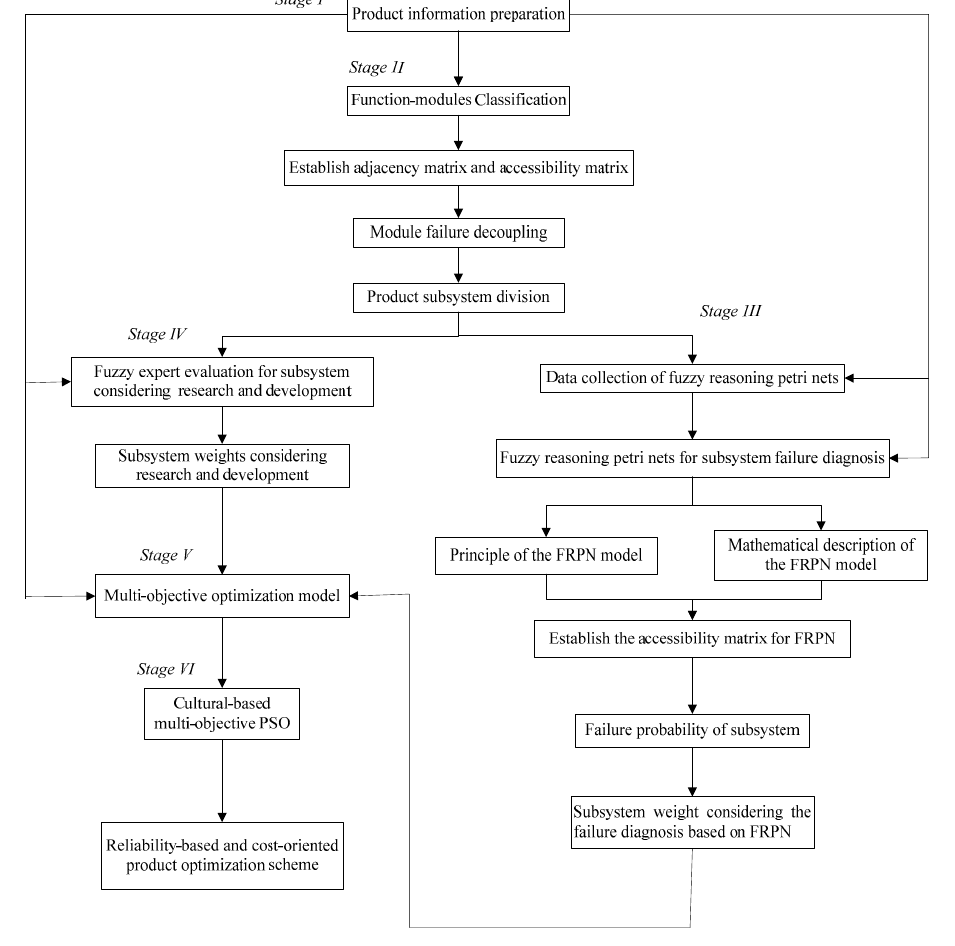
Figure 1. General framework of the proposed reliability optimization.